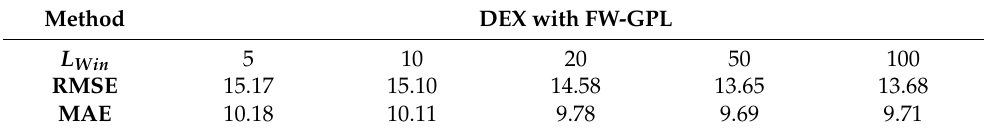
Table 8. Test performance of FW-GPL on testing data sets (length of output neurons set as 100). Method